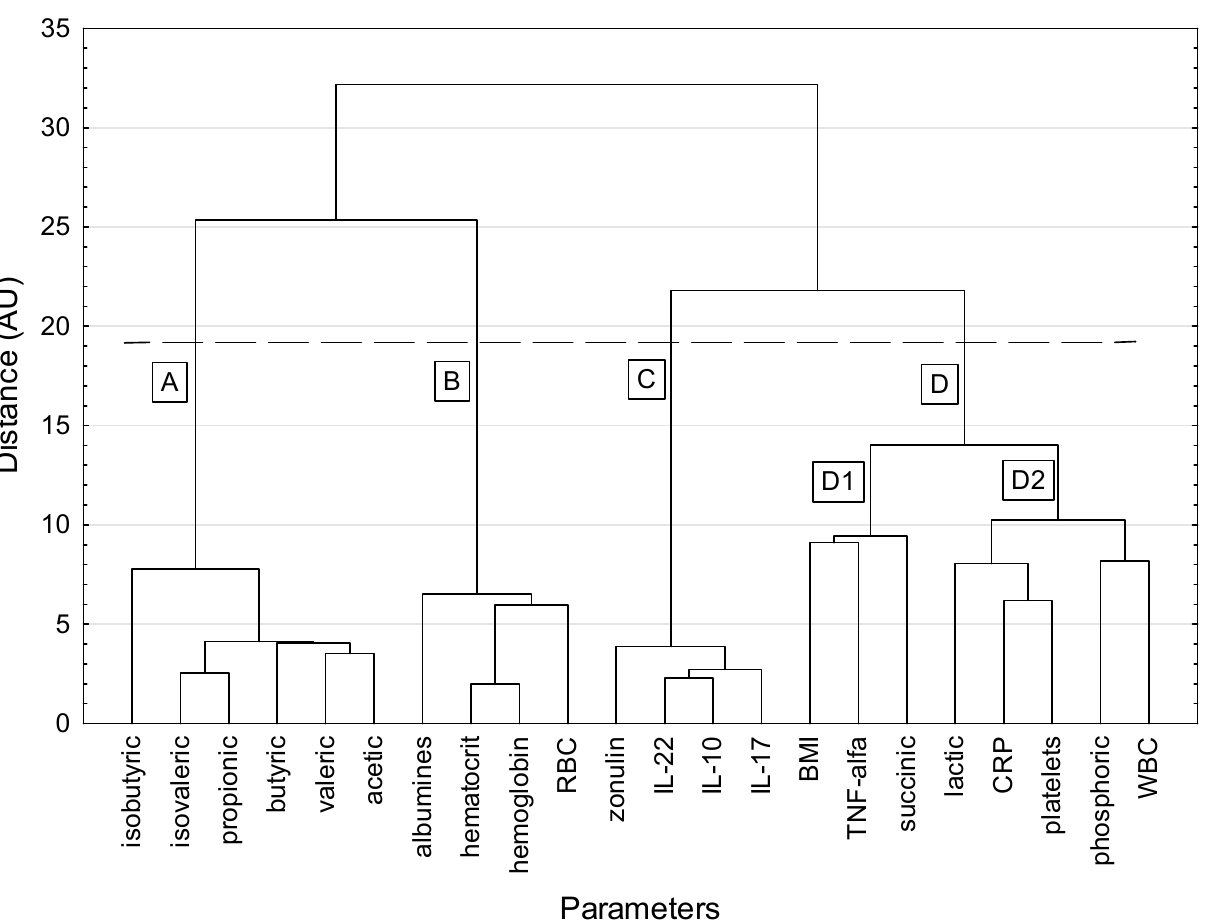
Figure 1. A dendrogram of similarity between studied parameters (method of grouping: Ward agglomeration; function of the distance: Euclidean distance; the dashed horizontal line indicates that grouping was stopped according to the Mojena’s rate). BMI: body mass index; CRP: C-reactive protein; RBC: red blood cells; WBC: white blood cells.